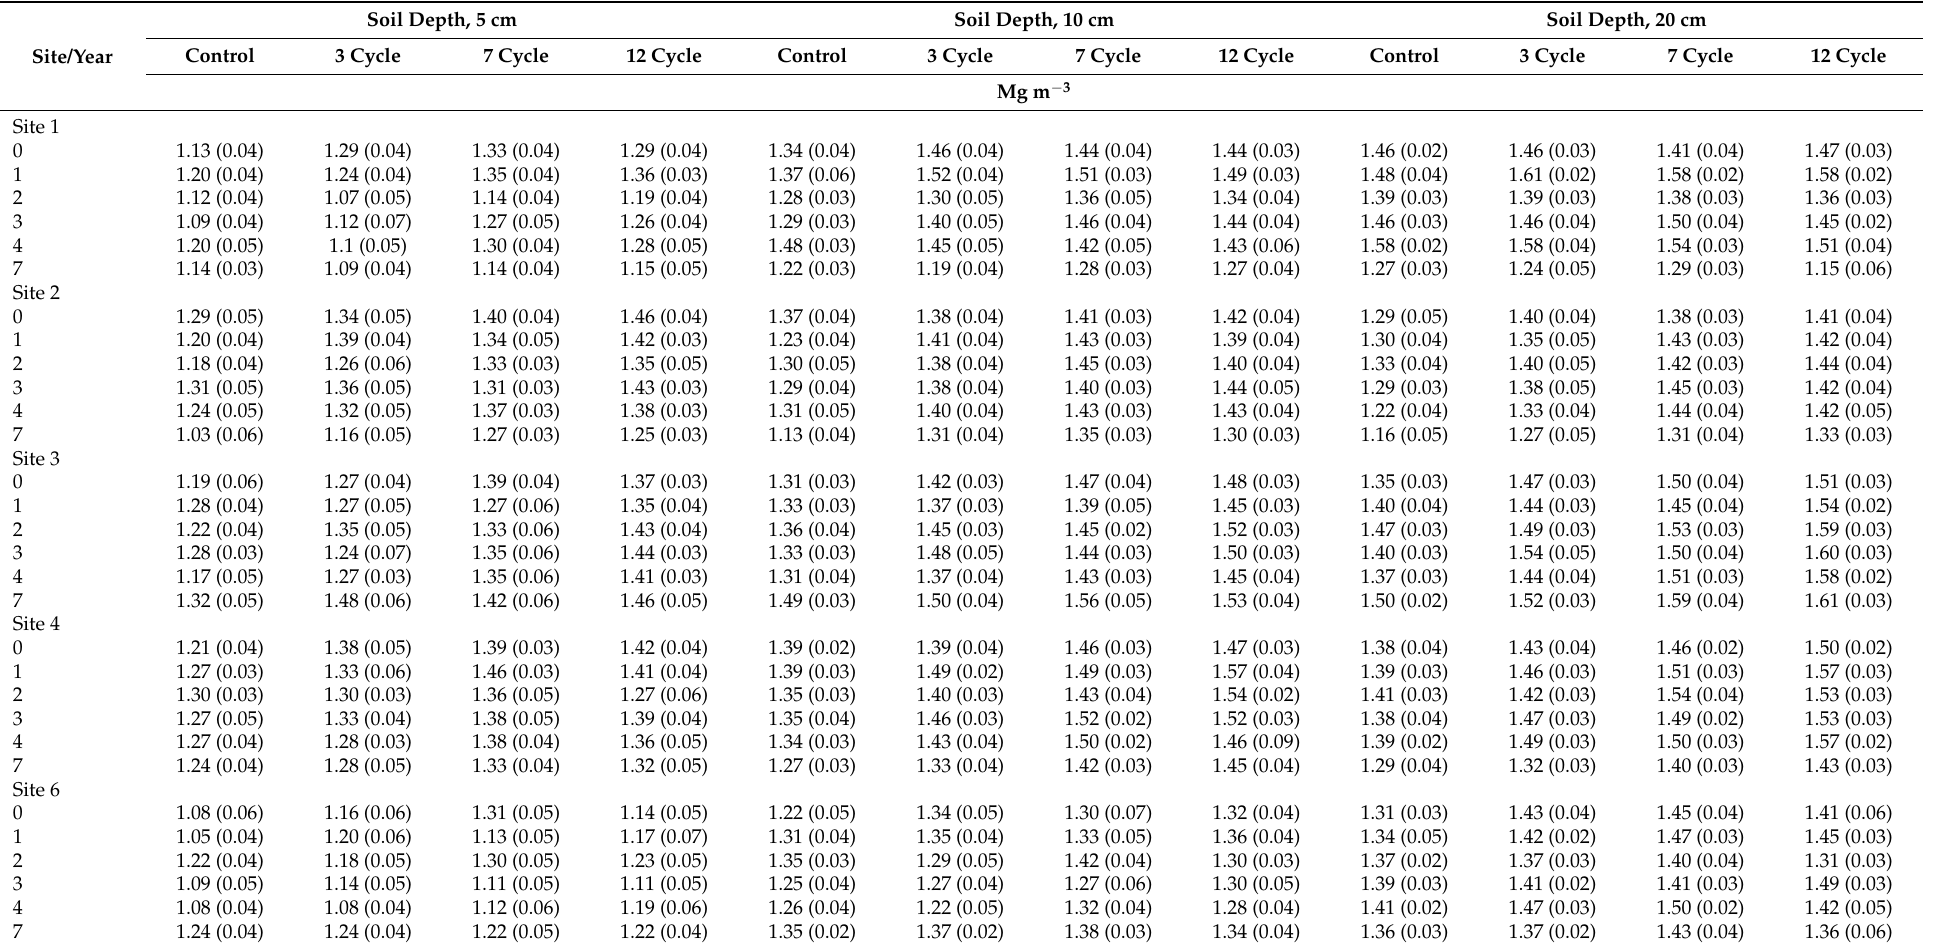
Table 2. Soil bulk density data for 9 sites, 4 treatments, 3 depths, and 6 sampling periods over 7 years. Soil depth is the average depth of a soil core with a height of 3 cm. The sample size was 16 and the standard errors are in